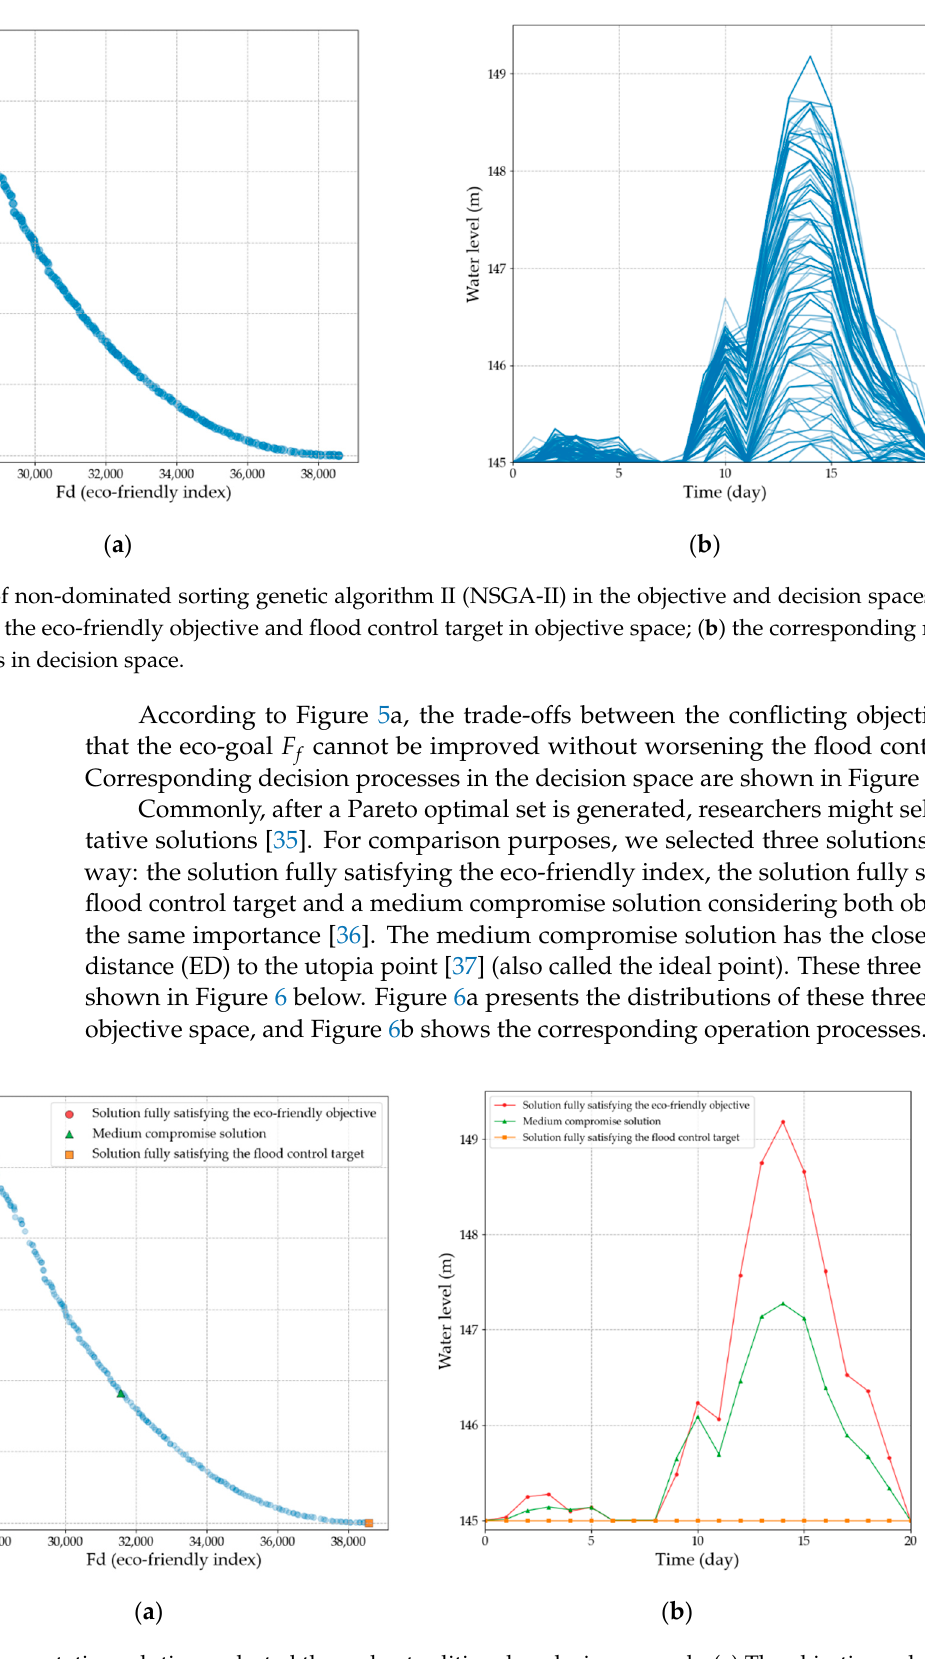
Figure 6. Three representative solutions selected through a traditional analysis approach. ( a ) The objective values of the representative solutions; ( b ) the corresponding reservoir operation processes of the representative solutions.